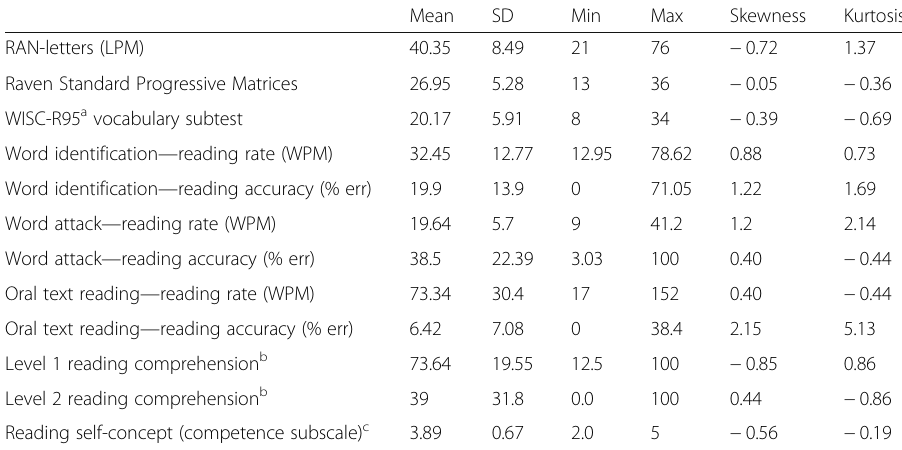
Table 2 The baseline descriptive statistics for the entire sample, in raw scores (pretest) Mean